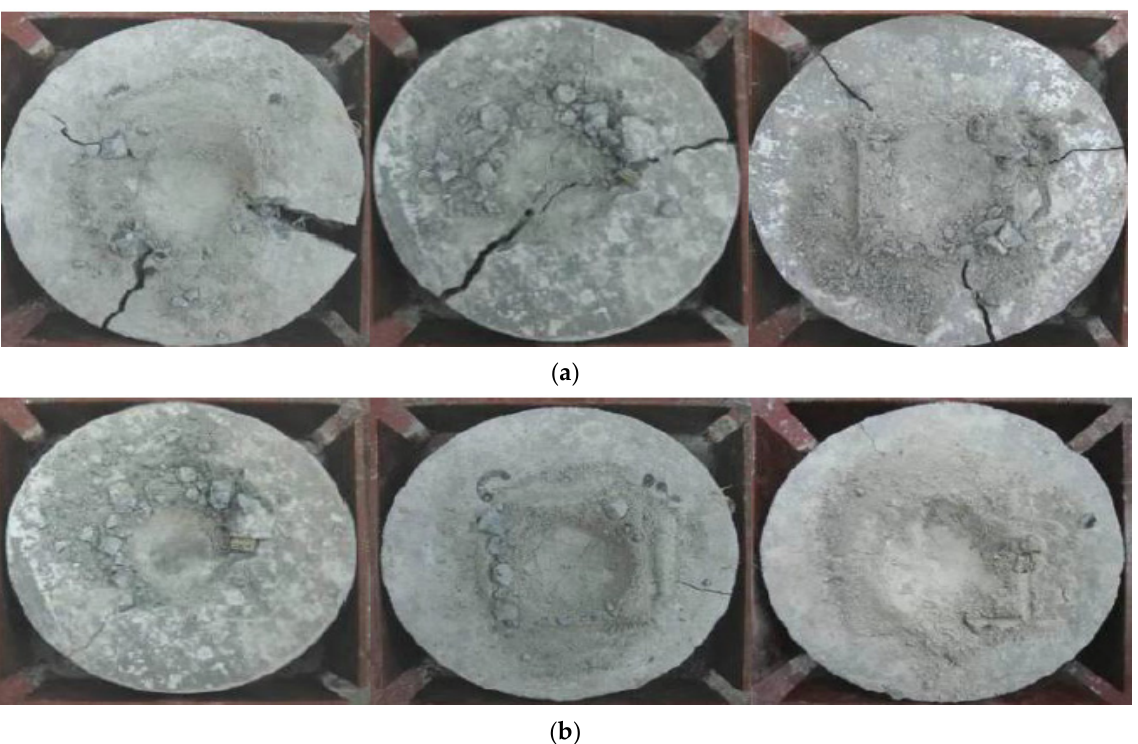
Figure 17. Failure Modes (Impact Resistance): ( a ) Control and ( b ) Basalt Fibers Reinforced Concrete [88].